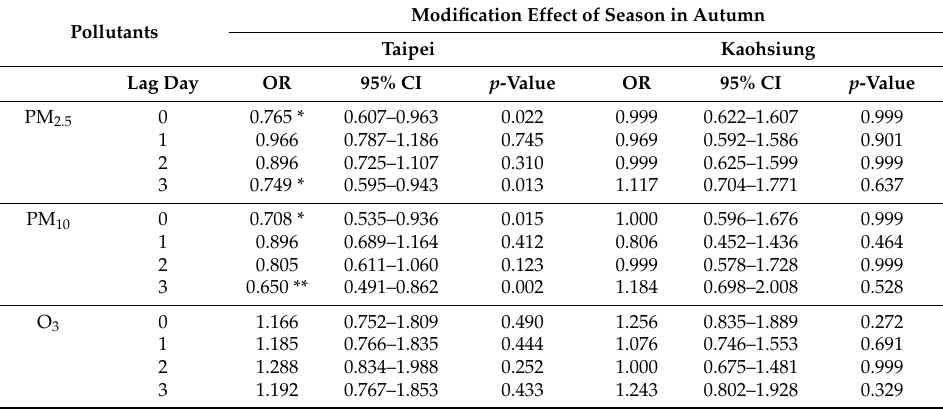
Table 6. Association between air pollution and childhood asthma in